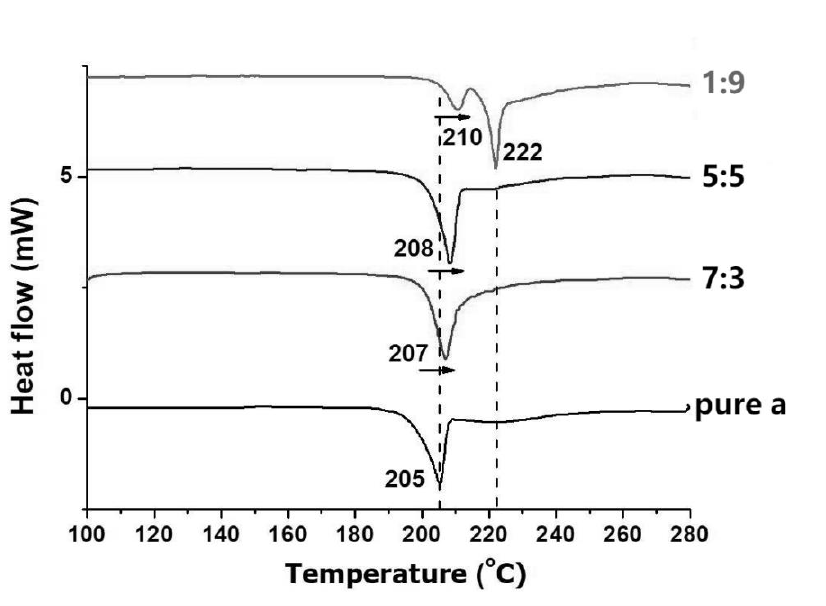
Figure 3. DSC spectra of the pollen-like anhydrous lactose with tailored α/β